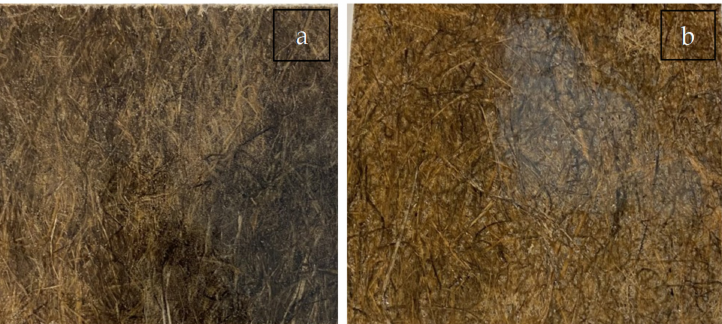
Figure 3. Specimens ( a ) 30 wt.% hemp reinforced PLA composite and ( b ) 50 wt.% hemp reinforced PLA